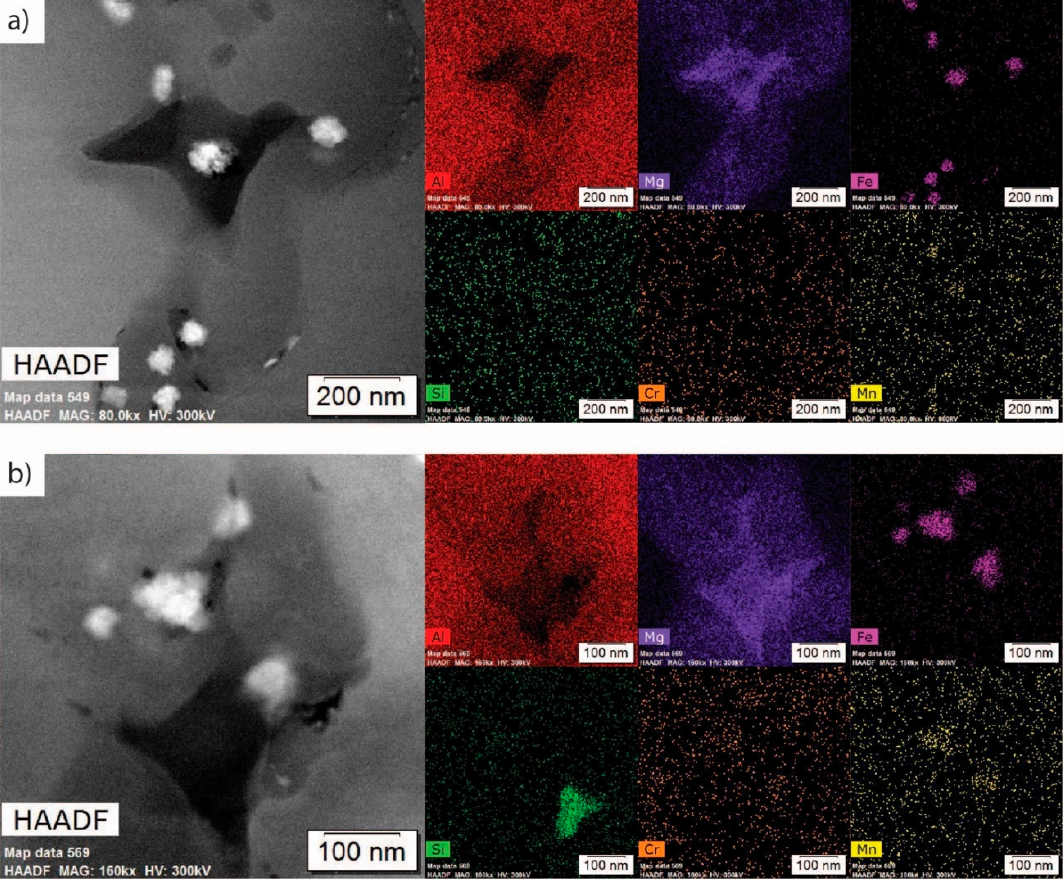
Figure 4. High-magnification TEM micrographs of the as-atomized condition showing ( a ) a grain boundary with an Fe intermetallic (light contrasting) and an Al-Mg phase (dark contrasting), as well as Mg segregation; ( b ) a grain corner featuring the same Fe intermetallic (light contrasting), a Mg-Si phase (dark contrasting), and two morphologies of the Al-Mg phase.